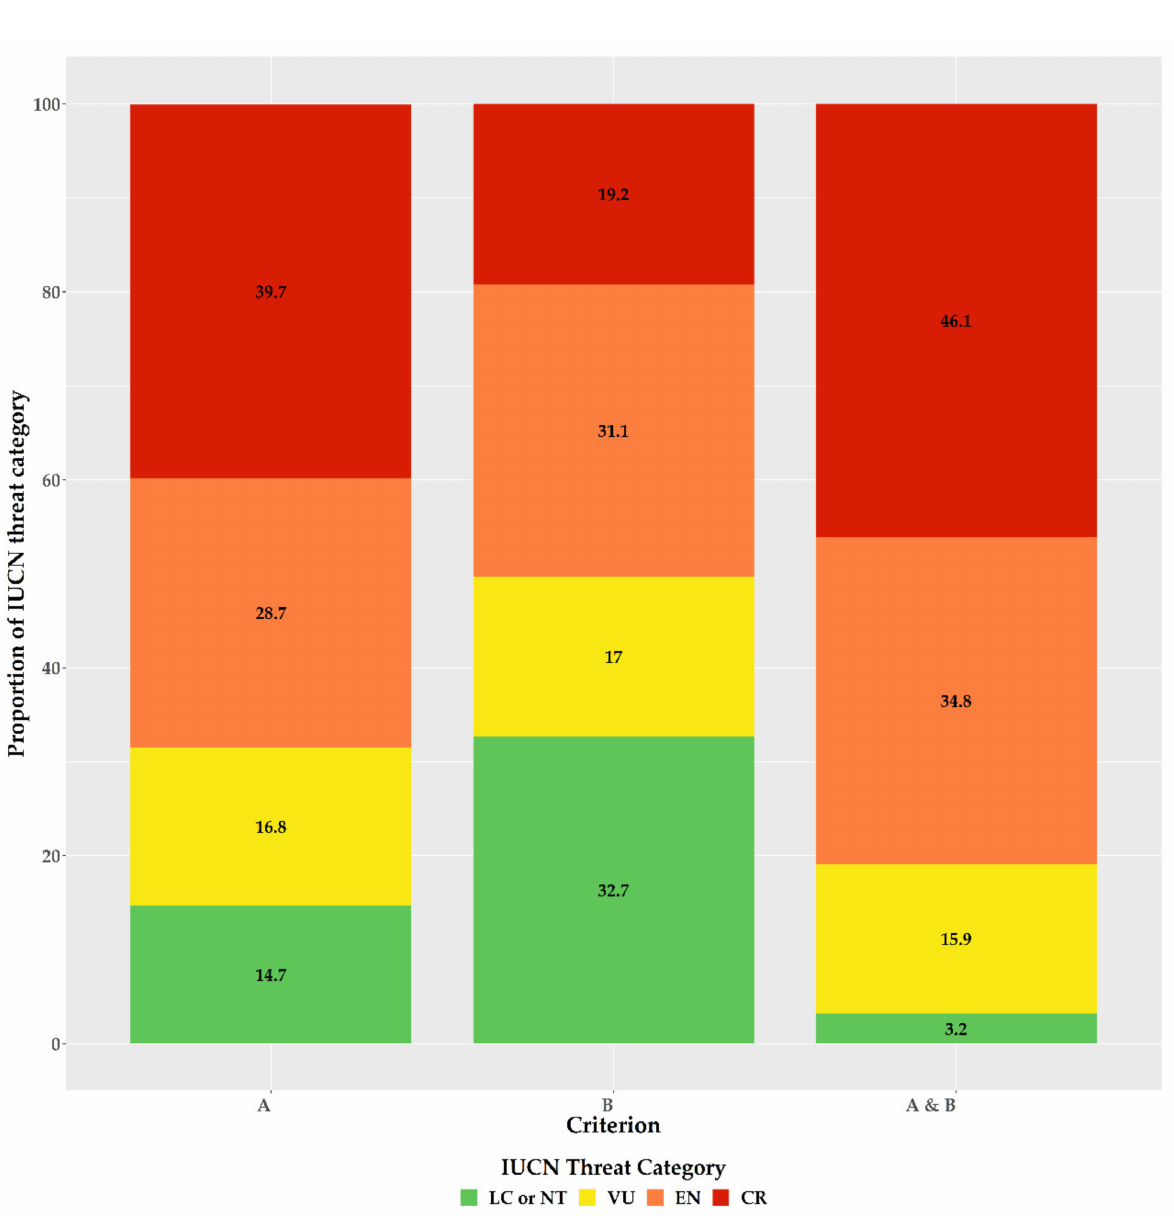
Figure 3. Proportion of the Greek endemic taxa under the IUCN threat categories according to Criterion A, Criterion B, and both Criterion A and B (from left to